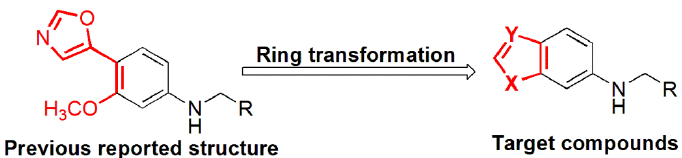
Figure 1. The chemical structure of the designed target